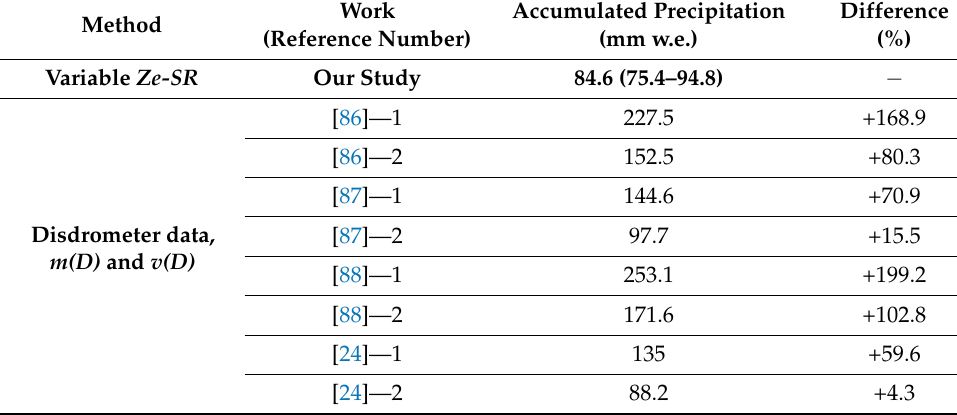
Table 3. Total precipitation estimation for the considered snow episodes calculated by different methodologies and relationships, specified in the first and second column, respectively. Note that 1 and 2 in the second column indicate the use of v(D) relationships for classes of aggregates (1) or of pristines (2) derived from [79]. Differences in the last column are with respect to our snow